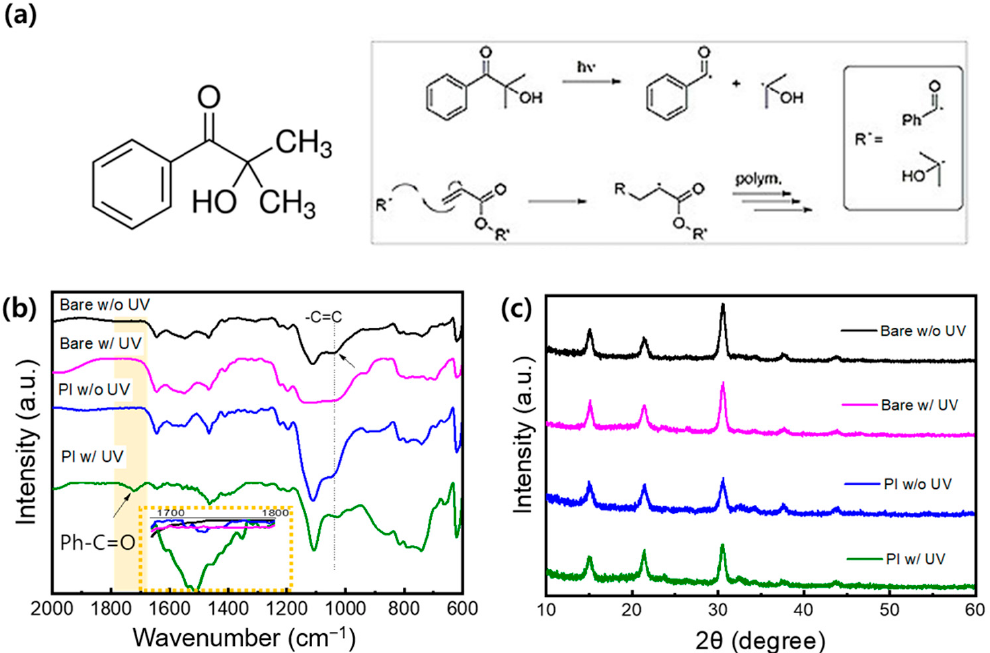
Figure 4. ( a ) Molecular structure of photo initiator and their reaction mechanism. ( b ) FT-IR spectra of as-coated film (Bare w/o UV), as-coated film after UV exposure (Bare w/UV), film of CsPbBr 3 /SiO 2 NCs with photo initiator before UV exposure (PI w/o UV), and film of CsPbBr 3 /SiO 2 NCs with photo initiator after UV exposure (PI w/UV). Inset demonstrated normalized FT-IR spectra range from 1680 to 1800 cm − 1 . ( c ) XRD pattern of corresponding film that was used in ( b ).